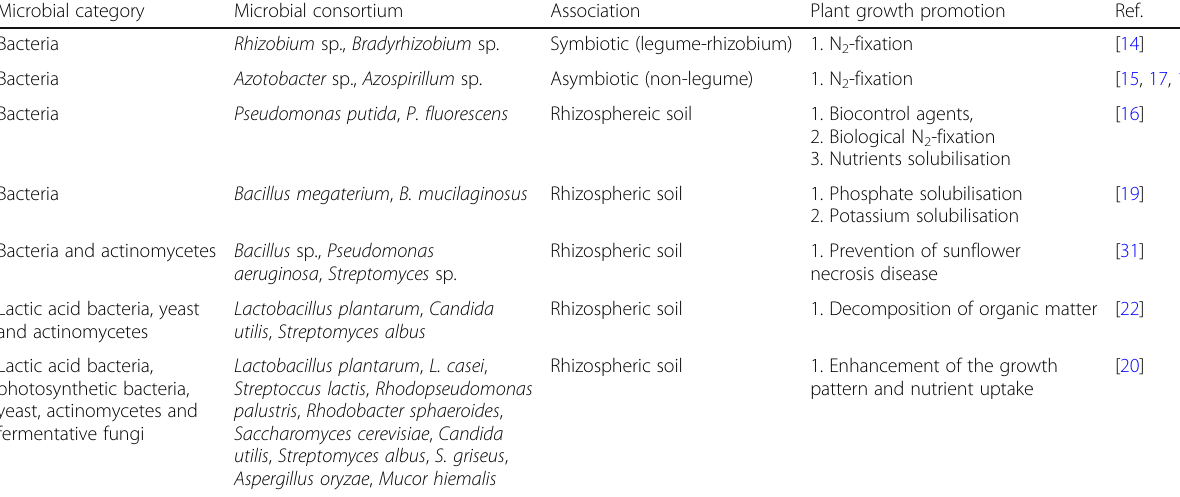
Table 4 Rhizosphere associated EMs and their impacts on plant growth Microbial